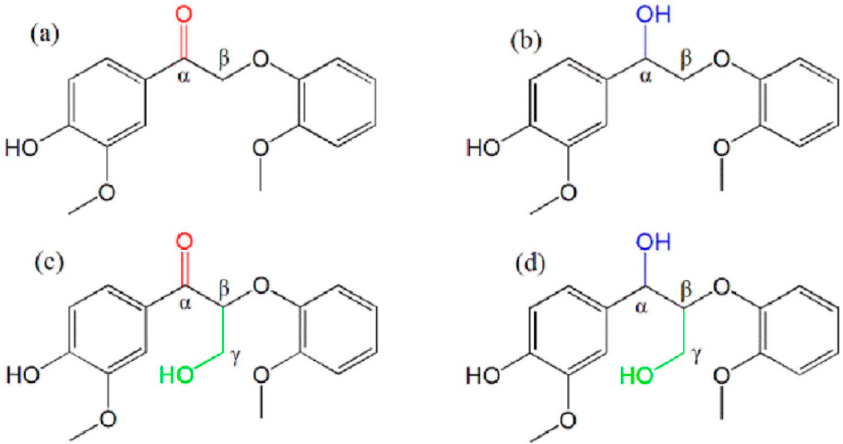
Figure 2. Molecular structures of four β -O-4 lignin dimer structures with different substituents at the C α and C β positions, reproduced with permission from [42], Copyright Elsevier, 2018.